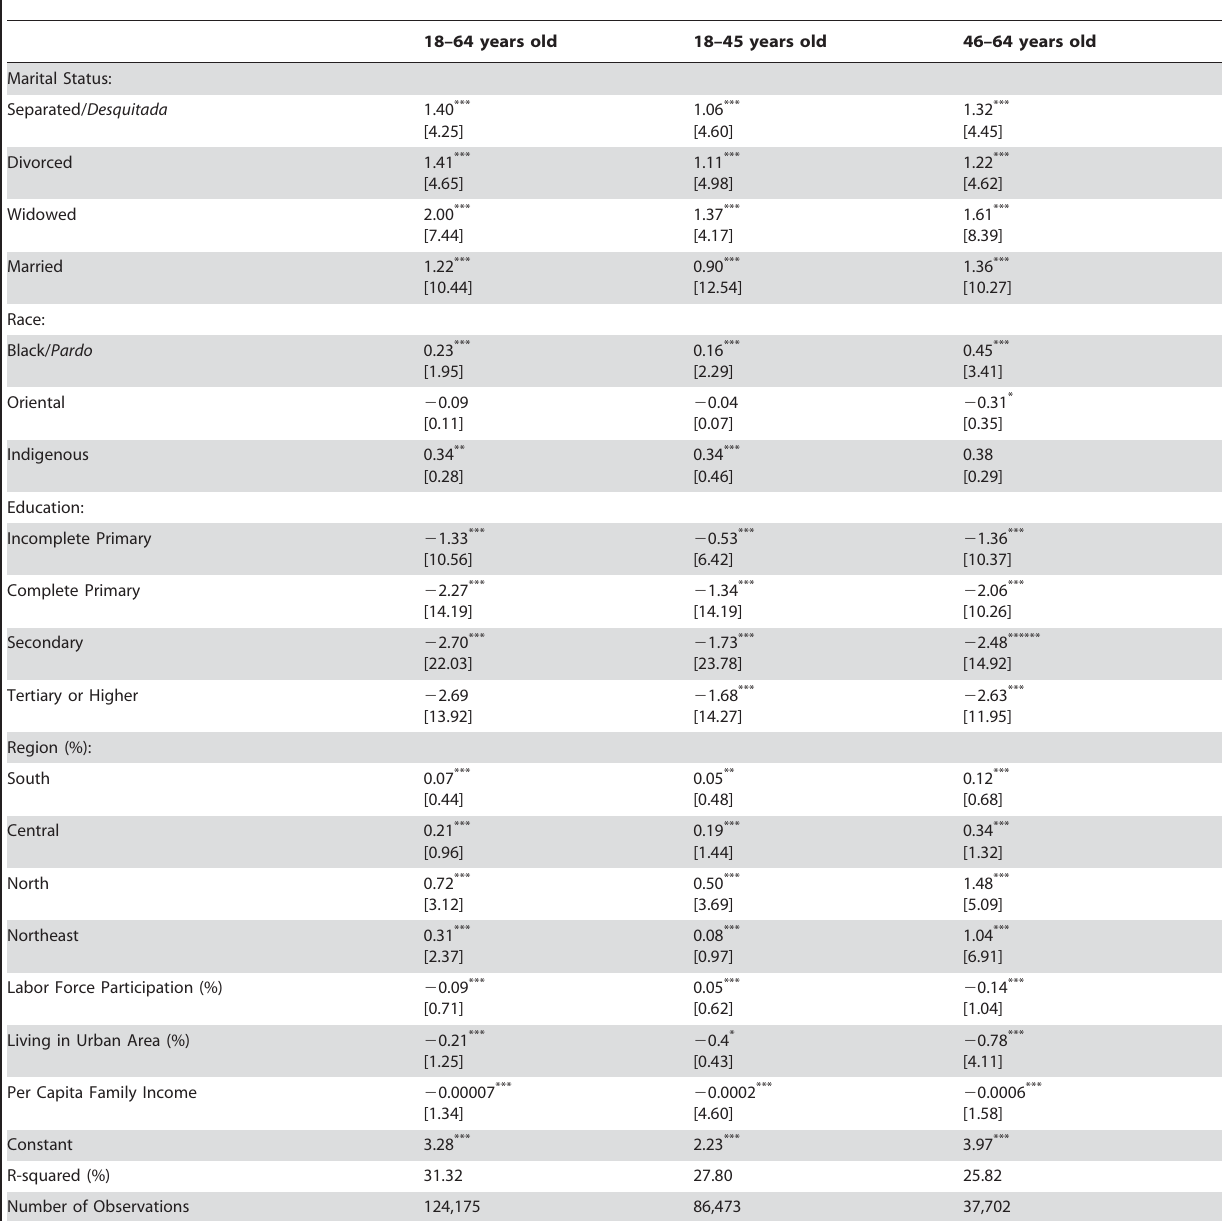
Table 2. Estimations and coefficients of partial contributions to the ‘‘number of children’’ - Equation